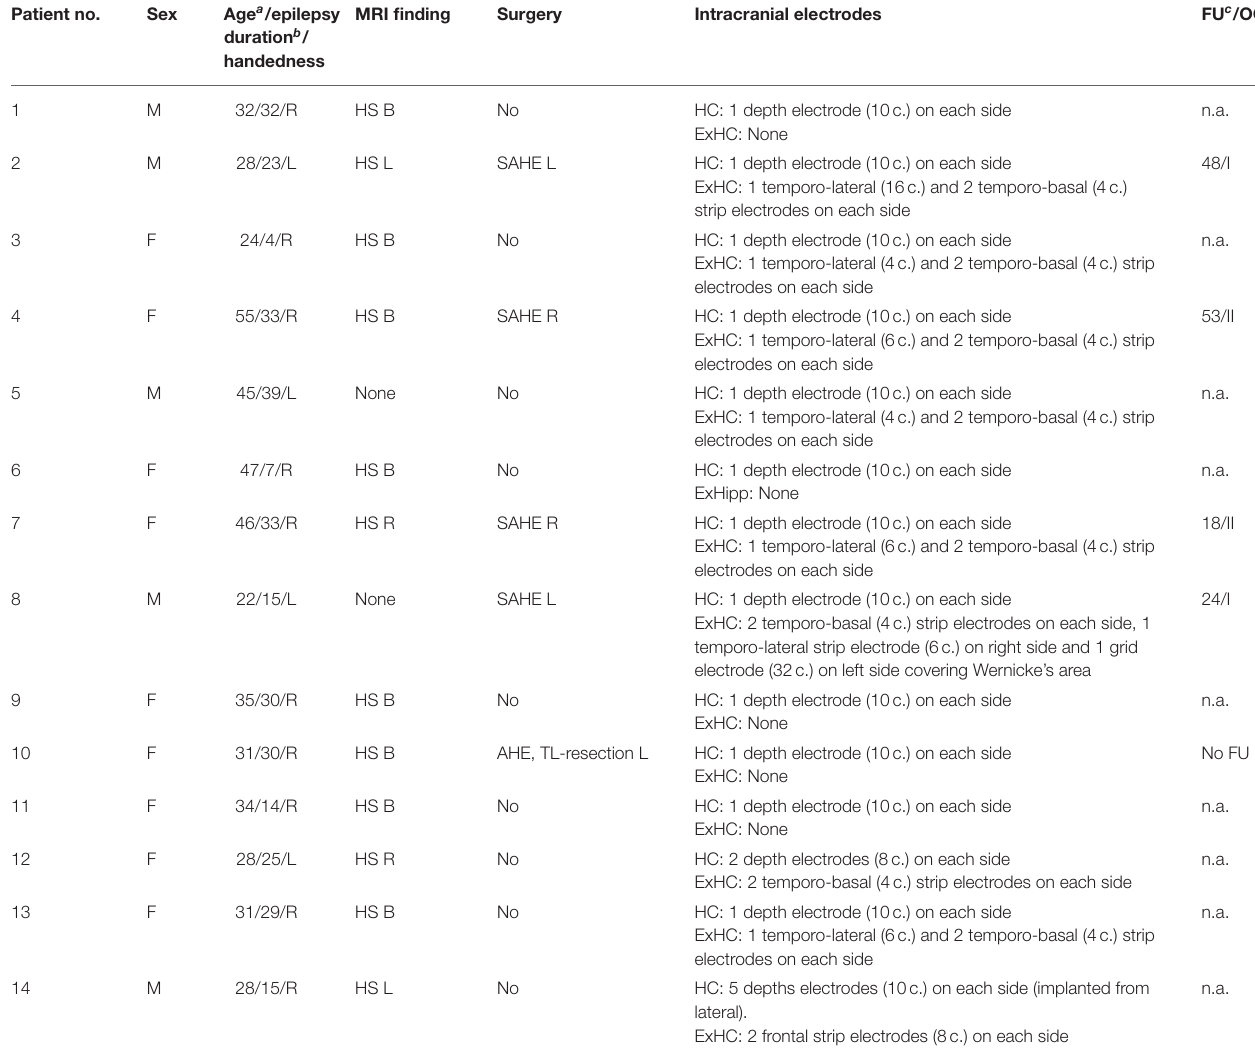
TABLE 1 | Clinical features of patients included in this study. Patient no.